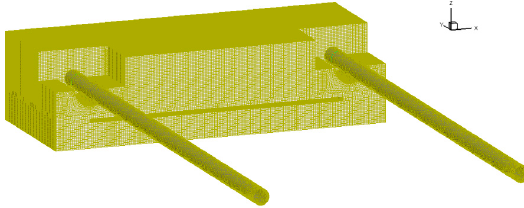
Figure 10. Schematic of block structured mesh used in this study.